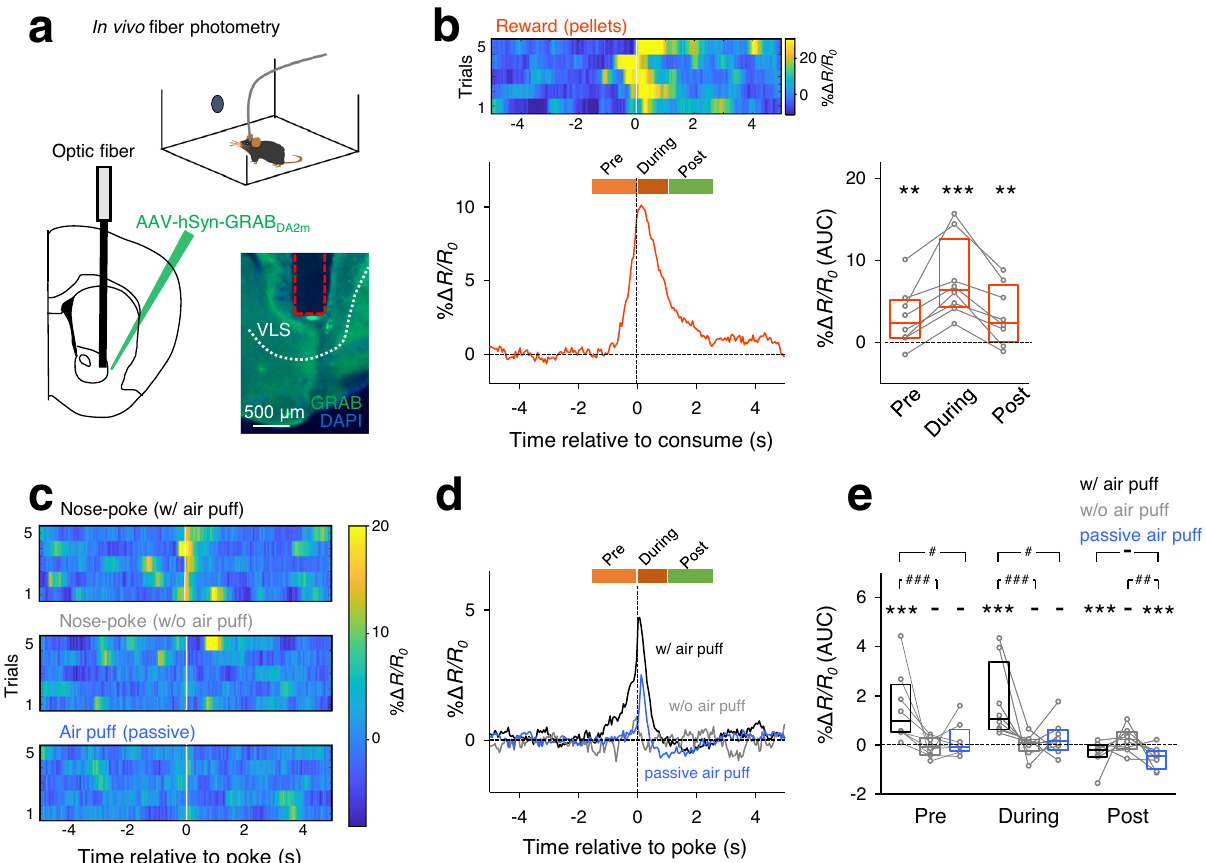
Fig. 3 | Dopamine is released in the ventrolateral striatum before nose pokes. a GRAB DA2m , a fl uorescent dopamine indicator, was expressed in neurons of the ventrolateral striatum and the fl uorescent signals were optically recorded through an optic fi ber during the behavioral test. b Top : Representative heatmap demon- strating that the GRAB DA2m signal increased during the consumption of food rewards. The pseudocolor scale represents the fl uorescence intensity change ( Δ R/ R 0 )over the baseline. Bottomleft : Mean Δ R/R 0 alignedto the onsets of 13 – 29pellet consumptions in 8 mice. The orange, red, and green bars above the plot indicate the preconsumption period, the during-consumption period, and the post- consumptionperiods,respectively. Bottomright :Theareaunderthecurves(AUCs) of Δ R/R 0 during these three periods. The box plots indicate the median and interquartile range. ** P =0.0034, 0.001 for the prepoke and the postpoke period, respectively. *** P <0.0001, n =8 mice, two-sided one-sample bootstrap test. c Representative heatmaps for GRAB DA2m signals relative to the onsets of nose pokes with air puffs (top), nose pokes without air puffs (middle), and passive